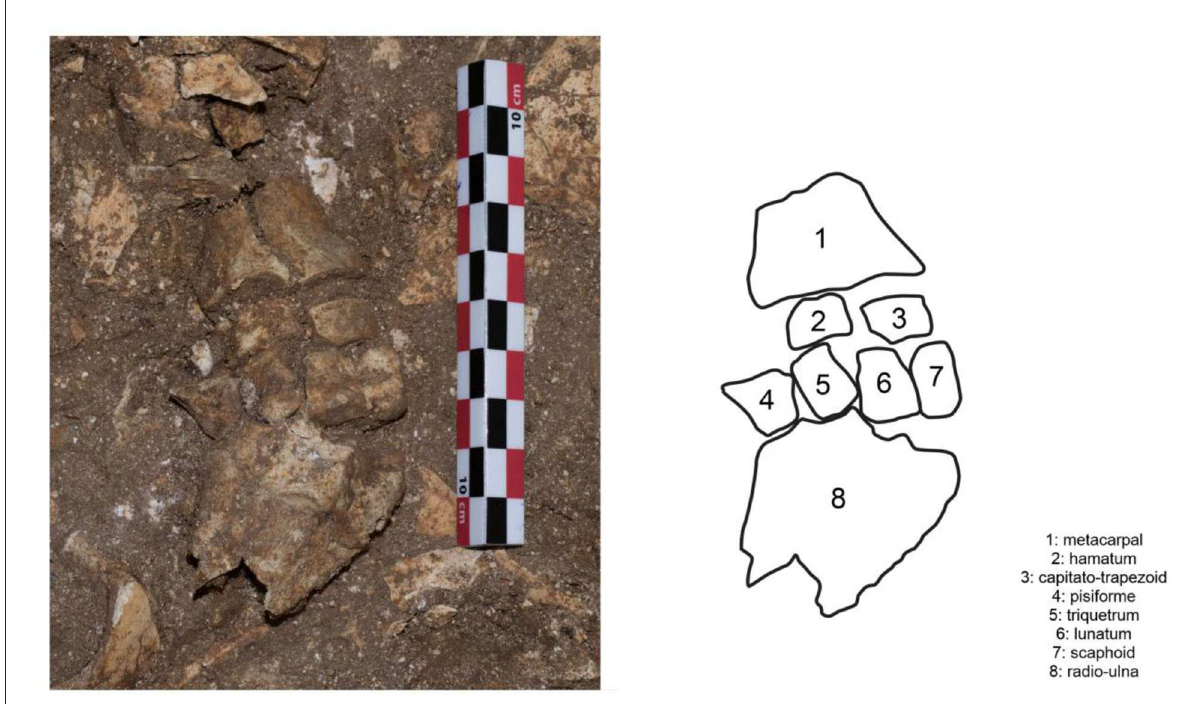
FIGURE2 Remains 6,218–6,225 in anatomical articulation found during decapage